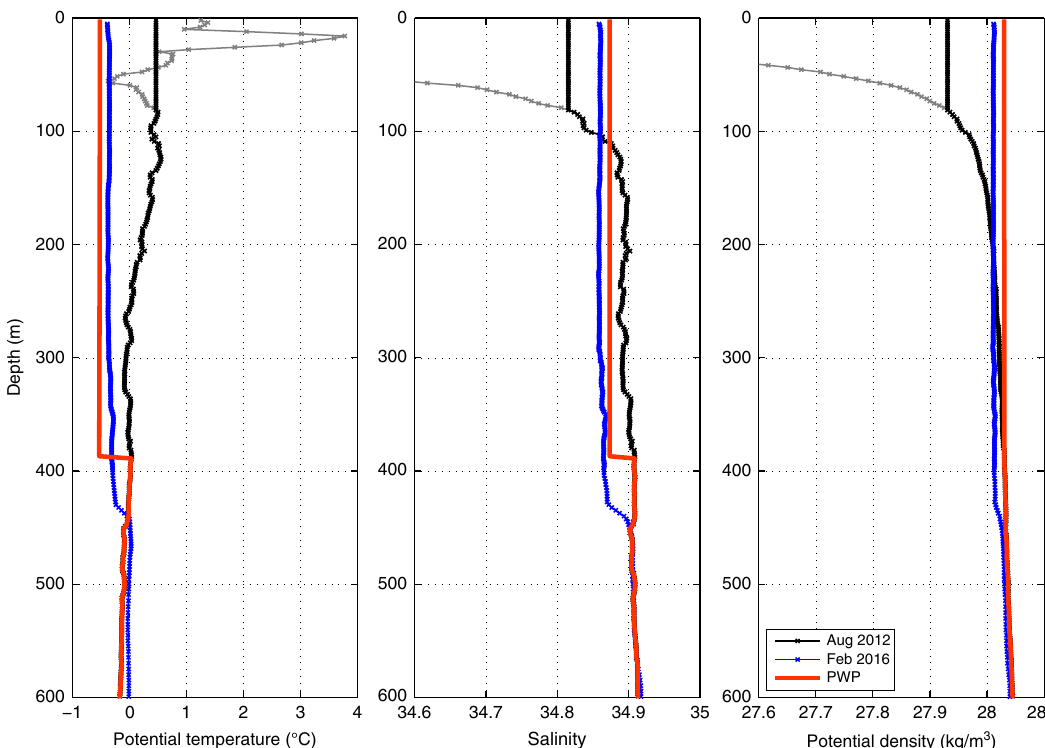
Fig. 6 Observed and modelled hydrographic pro fi les. Pro fi le from the August 2012 cruise modi fi ed to have a uniform 80 m deep mixed layer (in grey/black) that was closest to the February 2016 glider ’ s western turnaround point (pro fi le in blue). The red pro fi le is the result of a simulation by the one-dimensional PWP model using the modi fi ed summertime pro fi le as initial conditions and forced by a constant heat loss of 120 W/m 2 from November to